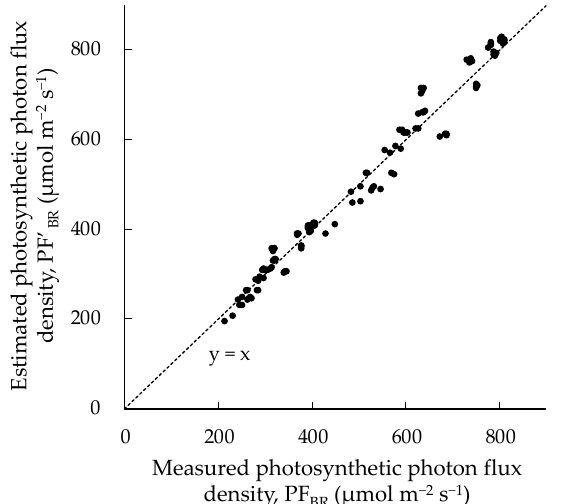
Figure 9. The relationship of the measured photosynthetic photon flux density (PF BR ) and the estimated photon flux density (RF’ BR ) on the cultivation shelf without plants (n = 124). PF BR was measured by a quantum sensor (LI-190, LI-COR Inc., Lincoln, NE, USA). These values were acquired under the conditions that 8 BRLED lamps were arranged at equal intervals at 41 cm in height, and the radiant flux of them was set at the maximum and half values. The dashed line is y = x.